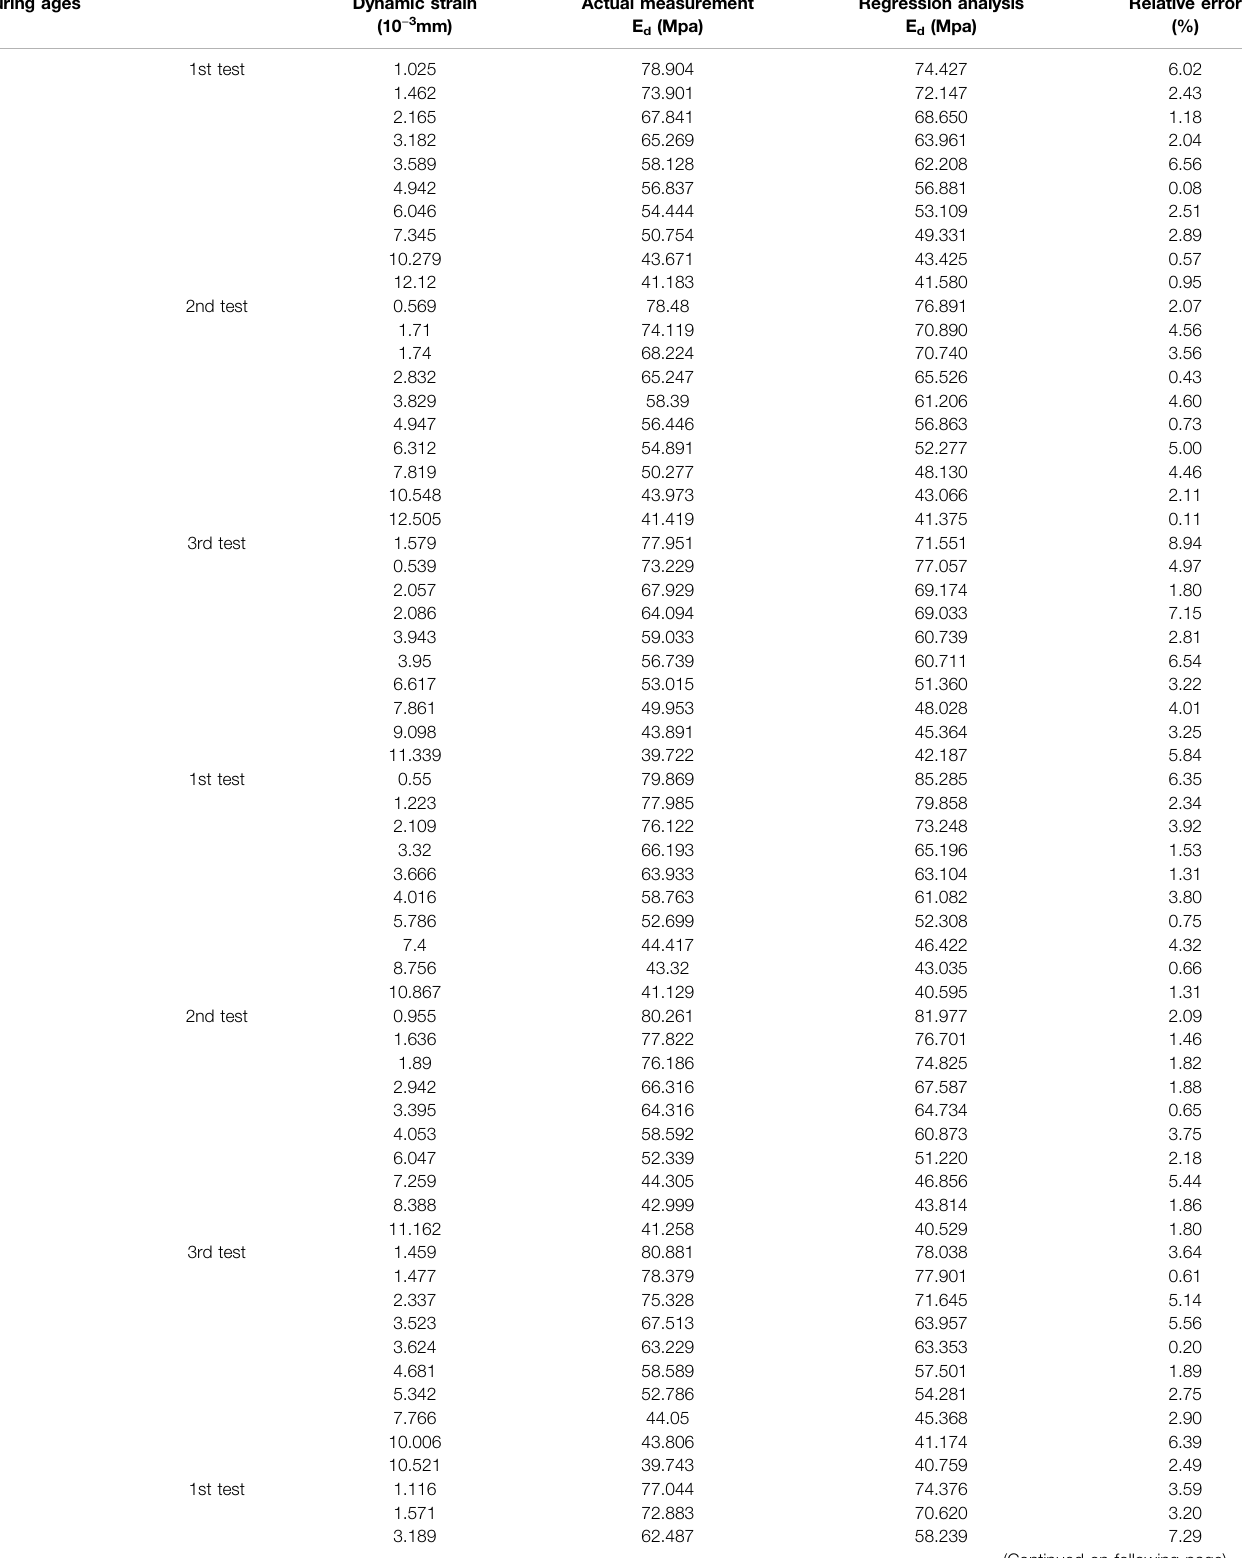
TABLE 6 | Dynamic elasticity modulus E d of solidi fi ed muddy soil at different curing ages. Curing ages